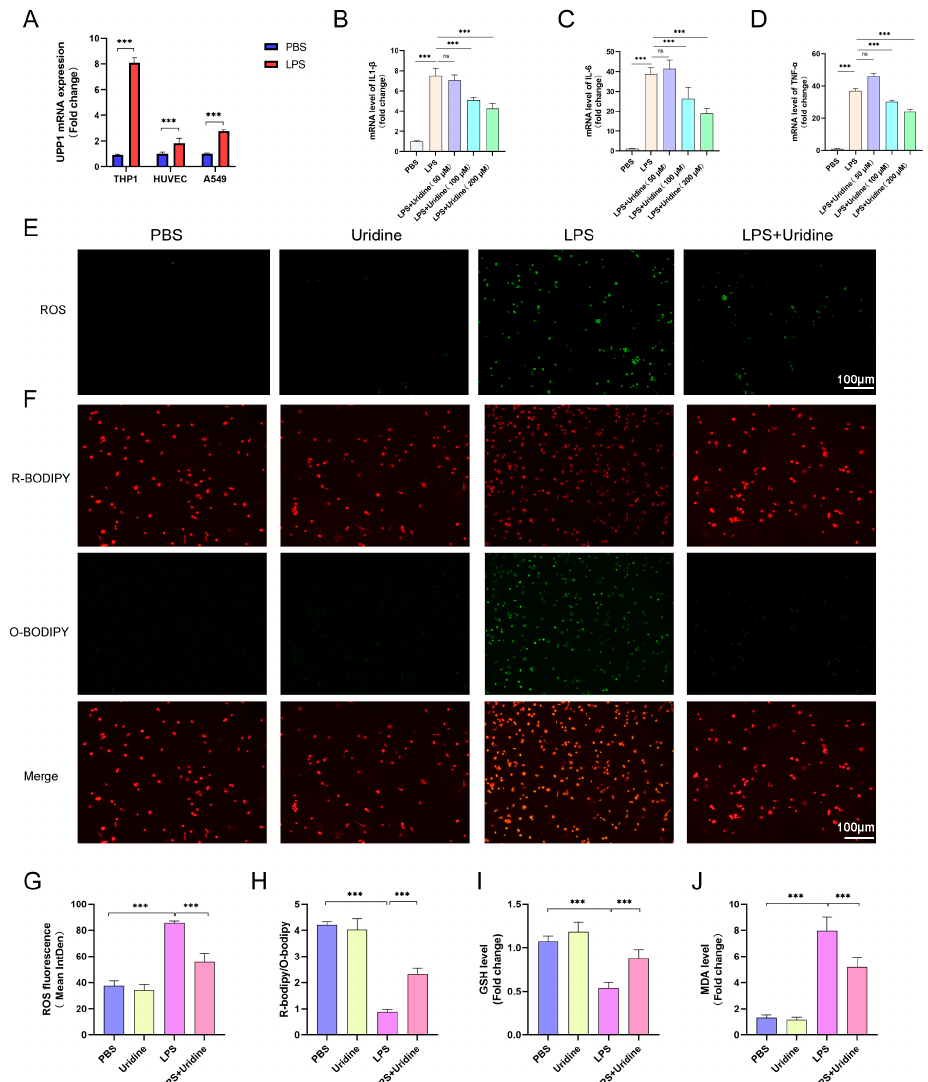
Figure 4. Uridine supplementation alleviated oxidative stress and lipid peroxidation in THP-1 cells. ( A ) Relative UPP1 mRNA expression levels after LPS (10 µ g/mL) stimulation 8 h in THP-1, HUVEC and A549 cells. ( B – D ) Relative mRNA expression levels of IL1 β , IL6 and TNF α in THP-1 cells after LPS stimulation with uridine supplementation in different concentration. LPS and uridine were almost simultaneously administrated. ( E ) Representative images of fluorescence probe for ROS in the indicated group in THP-1 cells after LPS stimulation with or without uridine (200 µ M) supplementation. ( F ) Representative images of fluorescence probe for lipid peroxidation in the indicated group in THP-1 cells. ( G ) The statistical results for ROS. ( H ) The statistical results for lipid peroxidation. Green and red fluorescence represents oxidative and reduced lipid respectively. ( I , J ) Relative GSH and MDA level in THP-1 cells lysates. n = 6 per group, (Data are presented as Mean ± SD, *** p < 0.001 compared with indicated group, ns, no